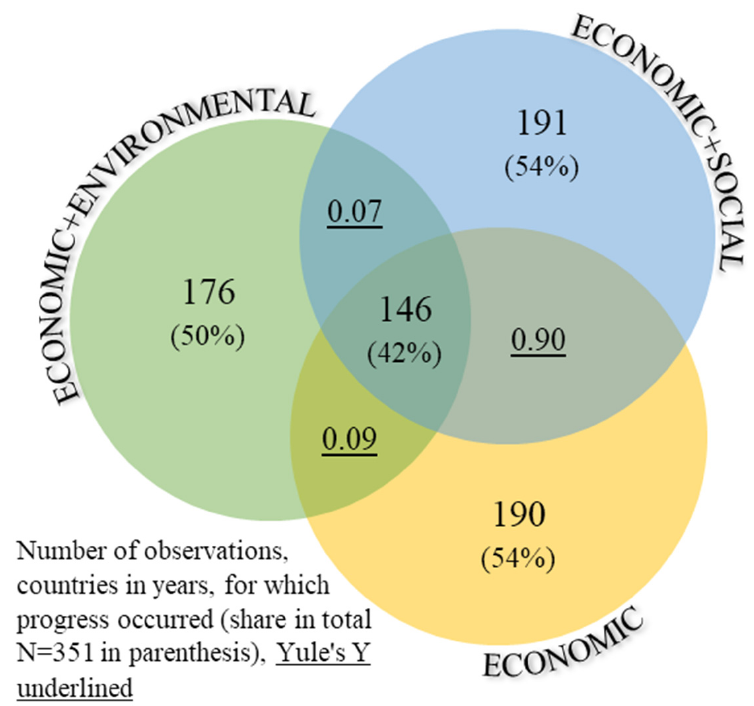
Figure 3. Breakdown of the progress toward sustainable intensification in EU countries in the years 2006–2018. Source: the authors’ study based on Malmquist TFP index and Eurostat data.